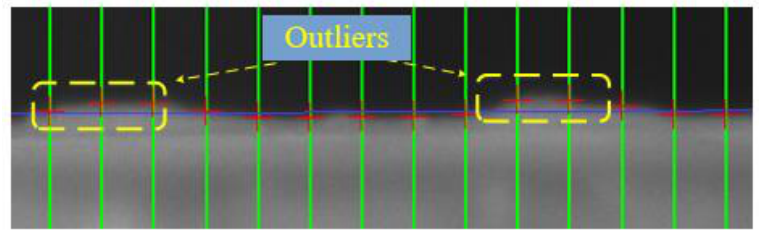
Figure 10. Schematic diagram of